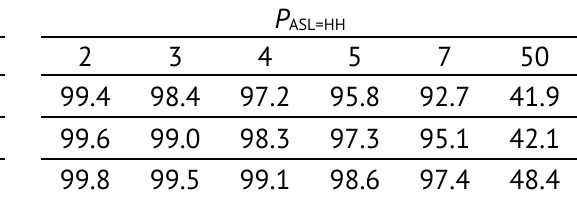
and P dependence to M and SL=d’H ASL=HH